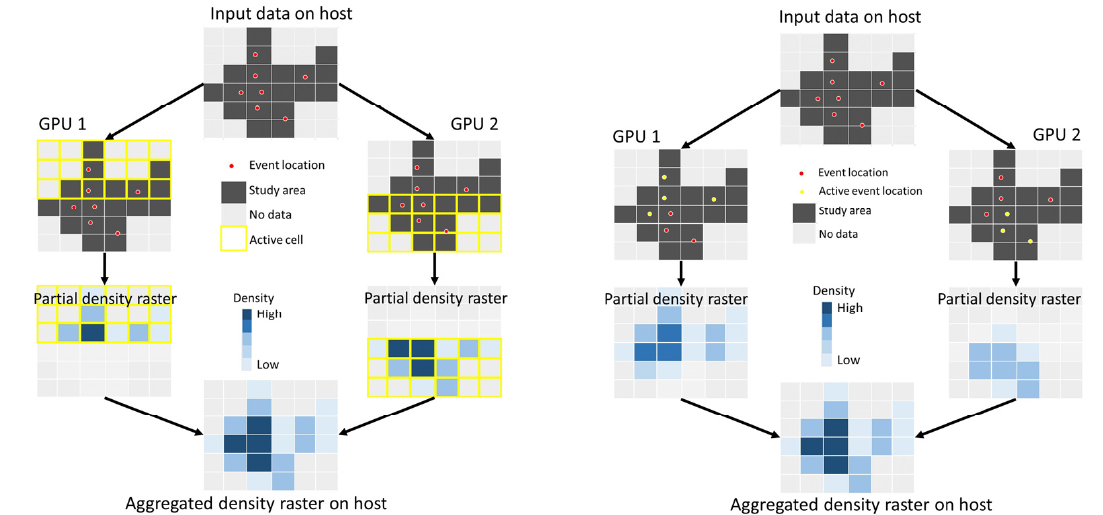
Figure 3. Cell-based parallelization ( left ) and point-based parallelization ( right ) of density raster estimation using multiple GPUs. Here, as an example, only two GPUs are used in the figure while the strategies apply to any number of GPUs.